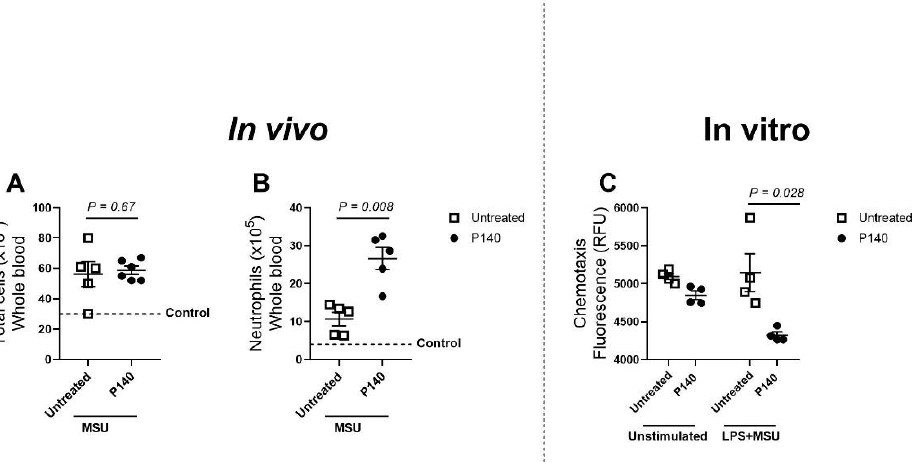
Figure 2. In vivo and in vitro effect of P140 on the presence of neutrophils in the peripheral blood in a model of gout. ( A ) Total cell counts measured by haemocytometer and ( B ) number of neutrophils measured by smear count determined in the peripheral blood of mice 15 h after MSU injection. Mice were pre-treated with P140 1 h before MSU crystal injection. ( C ) In vitro effect of P140 peptide on the neutrophil migration isolated from human peripheral blood and measured by Boyden cham- ber. CXCL8 was used to induce cell migration. Neutrophils were stimulated or not with LPS and MSU. The results are expressed in relative fluorescence units (RFU). Data are reported as mean ± SEM of 5 – 6 mice per group. p value was calculated using Mann-Whitney test. n.s= non-statistical.